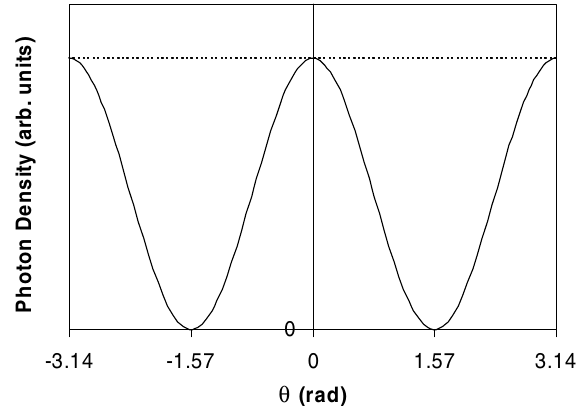
FIG. 3. Scattered photon density vs scattering angle ( (cid:24) ) from the z axis in the x - z plane (solid line) and the y - z plane (dotted line) for the case of an electron at rest and an x polarized photon incident along the negative z axis. ential cross section for the case of a head-on collision (cid:2) 0 ), with polarization in the x direction. To illustrate ( (cid:24) 0 the differences between the cross section for a nonrela- tivistic and relativistic electron, two cases ( (cid:15) (cid:2) 1 and (cid:15) (cid:2) 2 ) are illustrated. For the case of the nonrelativistic